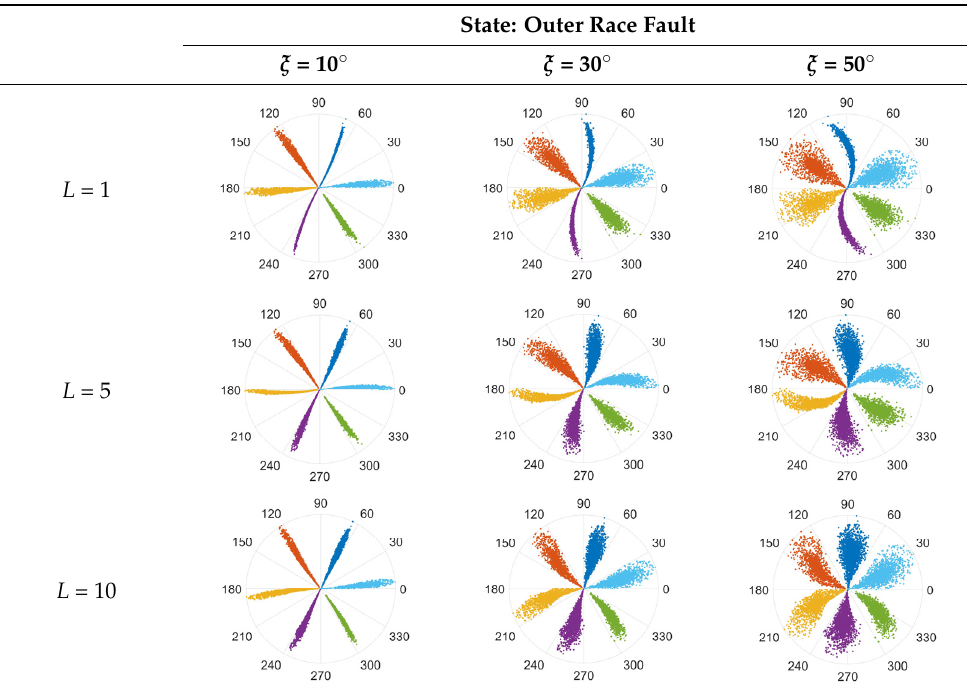
Table 2. M-SDP images with different internal parameters.